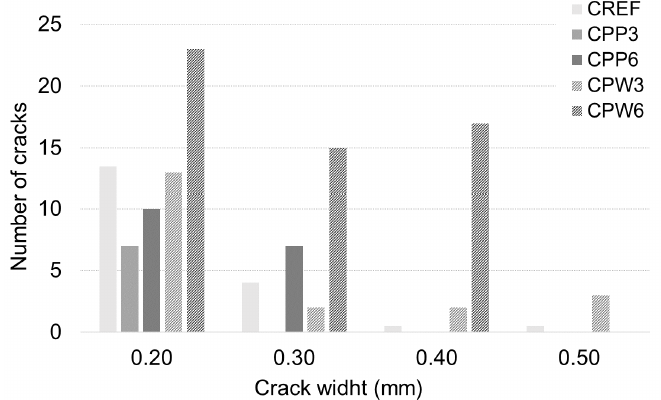
Figure 5. Cracking after exposure to high temperature.